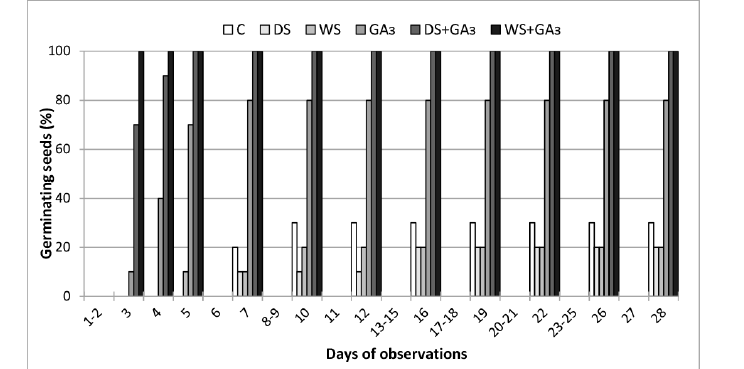
Figure 2 Dynamics of Primula farinosa seed germination after the application of factors breaking dormancy in 2012. C – control; DS – dry stratification; WS – wet stratification; − 3 GA 3 – 24-hr conditioning in 1.8 × 10 M GA 3 solution.